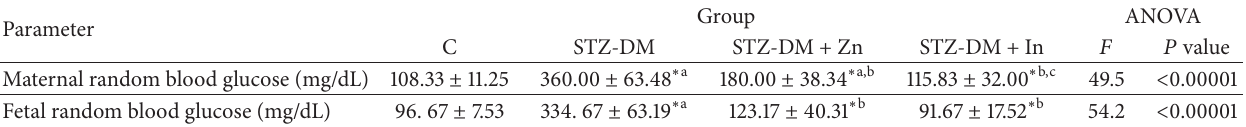
Table 1: Mean ± SD of maternal and fetal random blood glucose levels in the different groups. Parameter